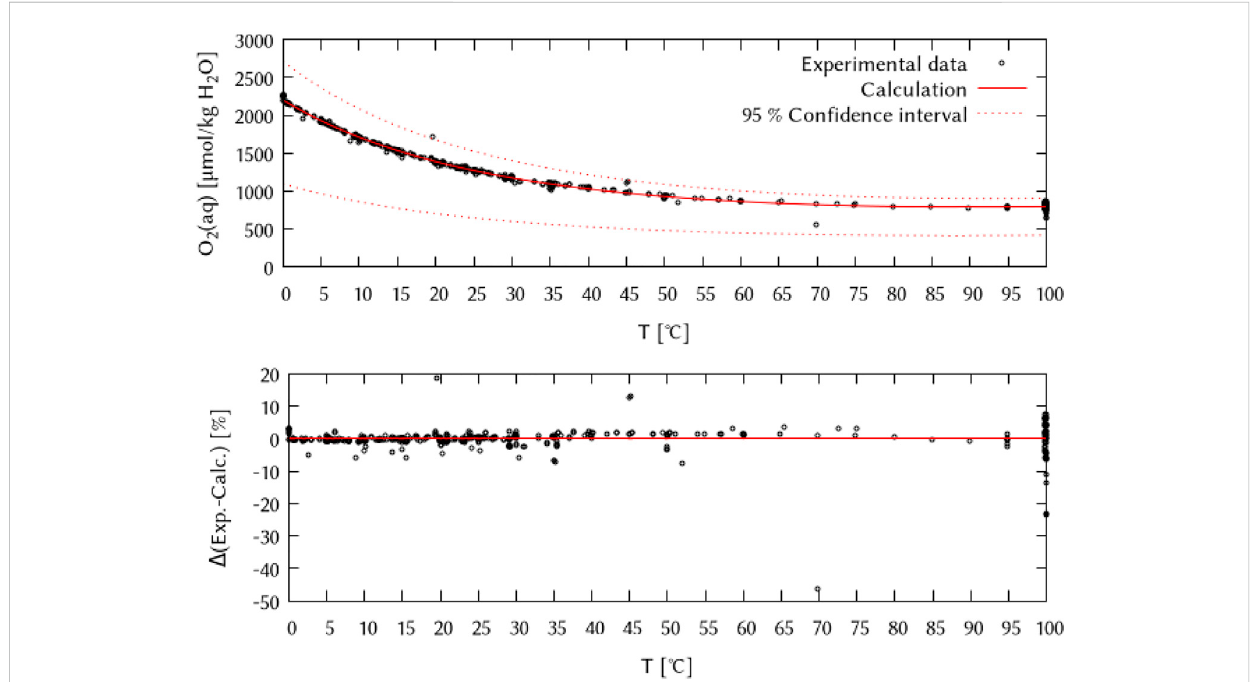
FIGURE 3 TemperaturedependencyofthelogarithmicHenry ’ slawconstantoftheO 2 solubilityinpurewater(expressedinµmol/kgH 2 O · 101.325 kPa).Points: experimental data from literature references given by IUPAC (Battino et al., 1981; Clever et al., 2014), solid line: calculation (this work), dashed line: 95% con fi dence interval.